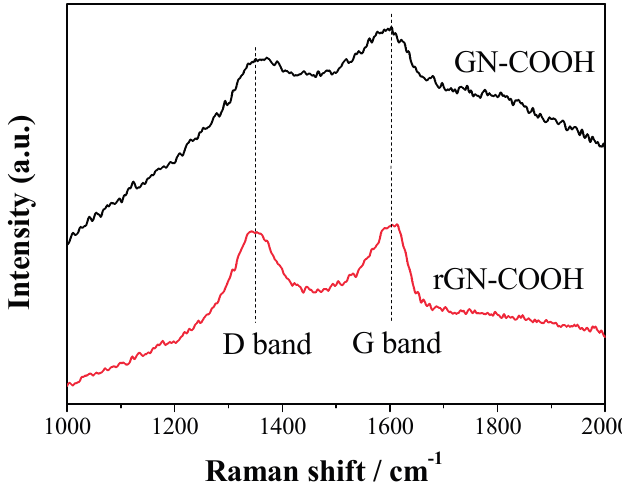
Figure 6. Raman spectra of GN-COOH and